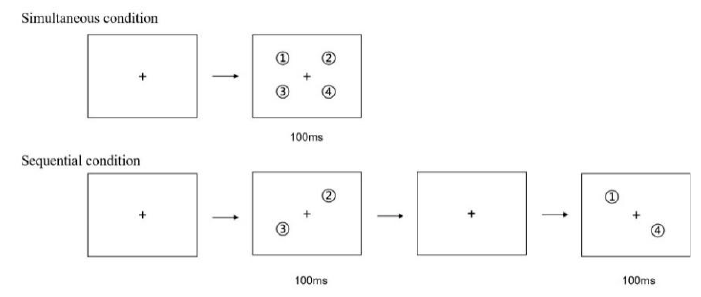
Figure 2. Simultaneous–sequential paradigm.